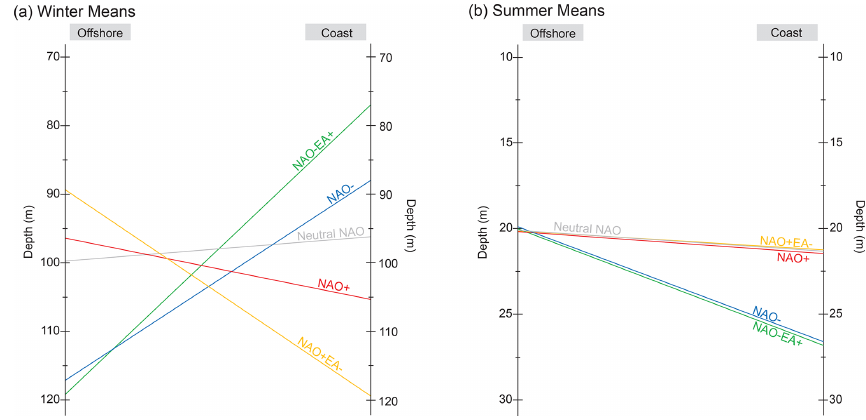
Figure 8. Schematic representation of the mean ILD for NAO and EA phases during winter (a) and summer (b)